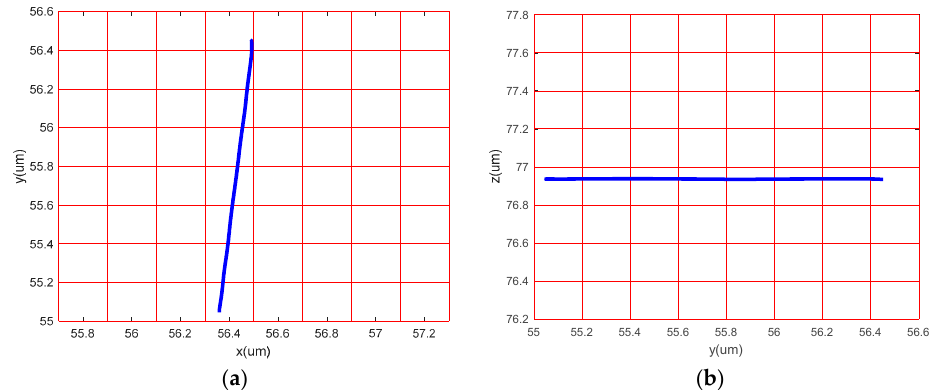
Figure 32. Linear motion performance test in y direction. ( a ) Projection on the xoy plane; ( b ) projection on the yoz plane.